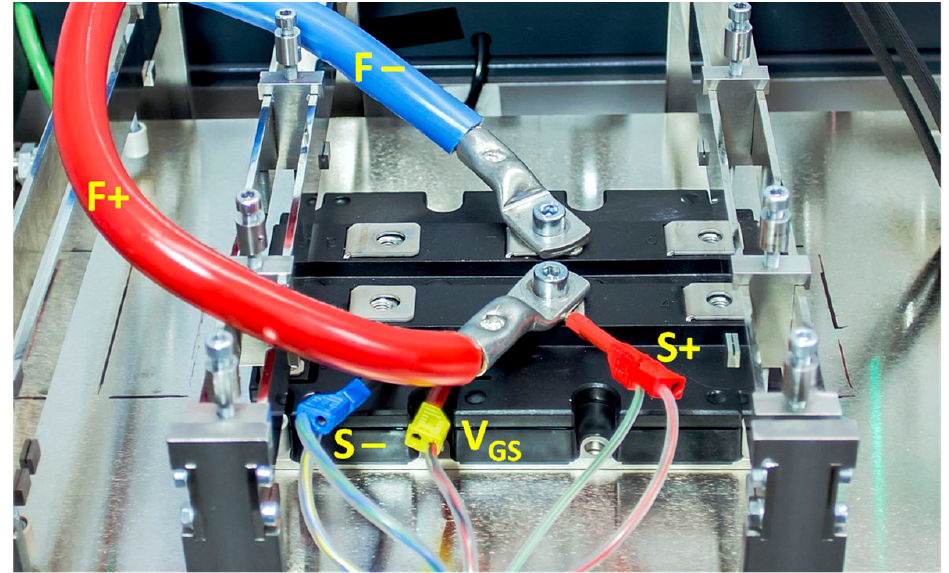
Figure A3. IGBT module prepared for TDIM measurement on cold plate. I H and I M applied on F+ and